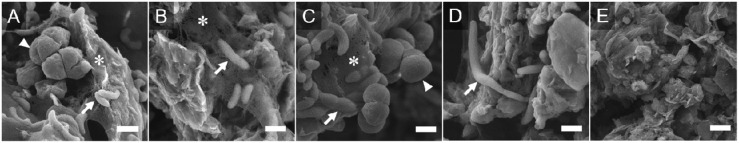
Field-Emission Scanning Electron Microscopy images of GO-based materials surfaces. Representative images of GO-based material surface morphology of exponentially growing cocultures are shown. Arrows indicate G. metallireducens. Arrowheads indicate M. barkeri. GO (A); rGO (B); rGO-NH2
(C); rGO-ODA (D); GO before cultivation (E). Bars, 1 μm. ∗Exopolysaccharide-like structure.